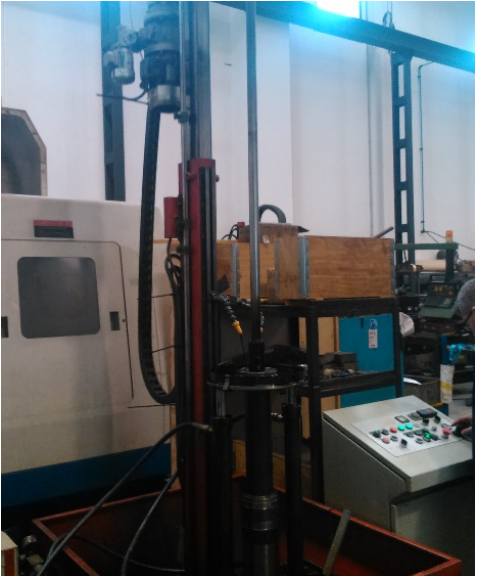
Figure 1. Industrial honing machine used in the experiment. A central composite design was used to define the experiments in each one of the honing steps (rough, semi-finish and finish), which is explained in Section 2.5. Honing time was 30 min in all experiments. Two replicates were performed for each experiment. Cubic boron nitride (cBN) honing stones were used with metallic bonds. Figure 2 depicts the honing head